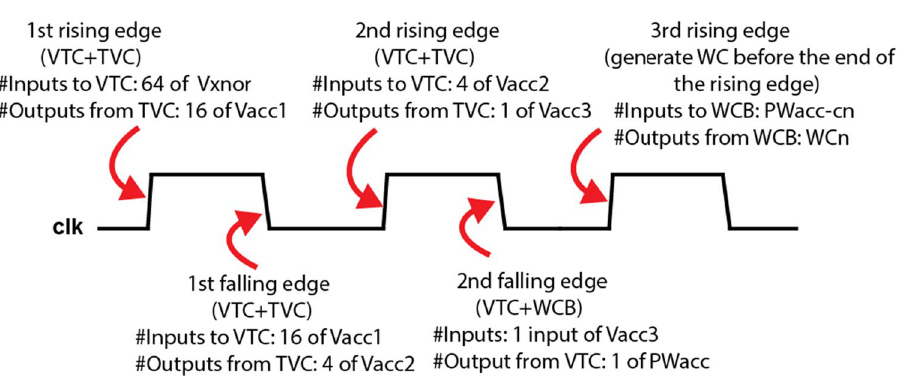
Figure 7. Detailed full hierarchy of the mixed-signal XNOR-based RRAM-CAM for HDC classification showing in ( a ) the 64 blocks of the divided query hypervector 10 × 16 arrays having VTC at the end of each row, then followed by( b ) time-based analog adder to combine entries class-wise from corresponding arrays, and eventually in ( c ) the winning class logic to decide upon the winner.